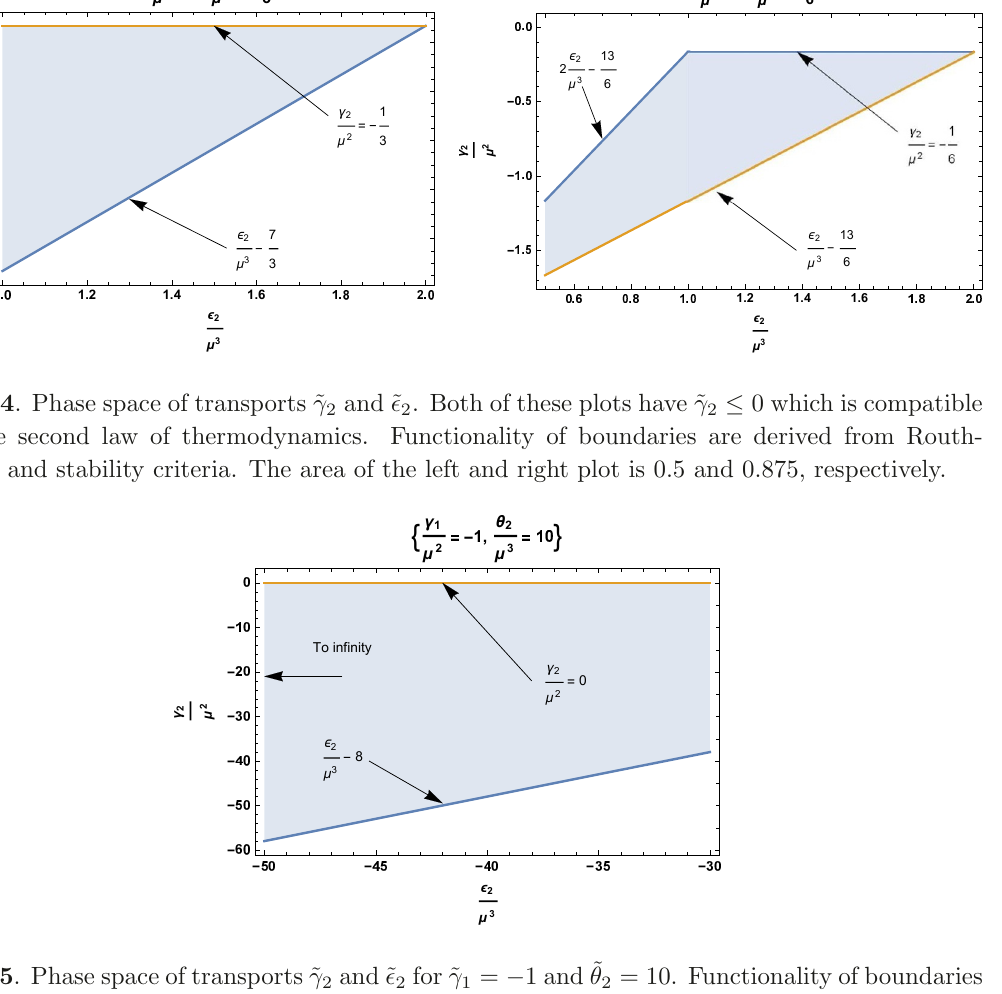
1 and ˜ θ 2 = 10. Functionality of boundaries −